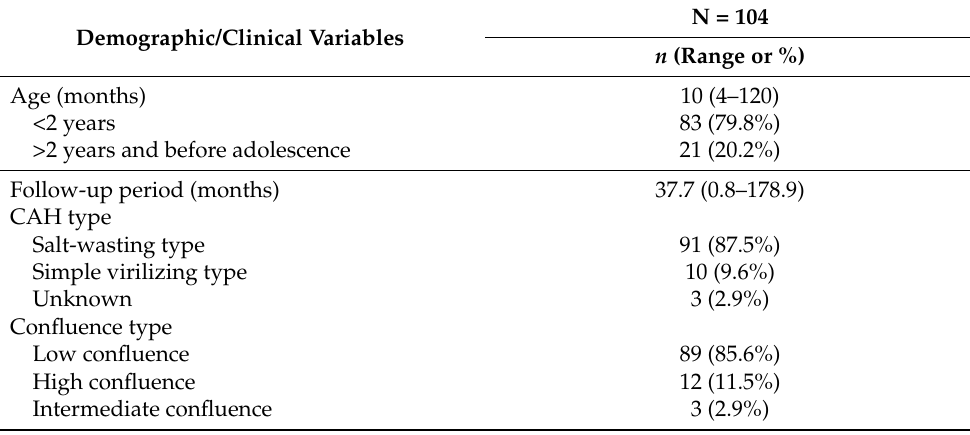
Table 1. Baseline demographic and clinical characteristics of patients.